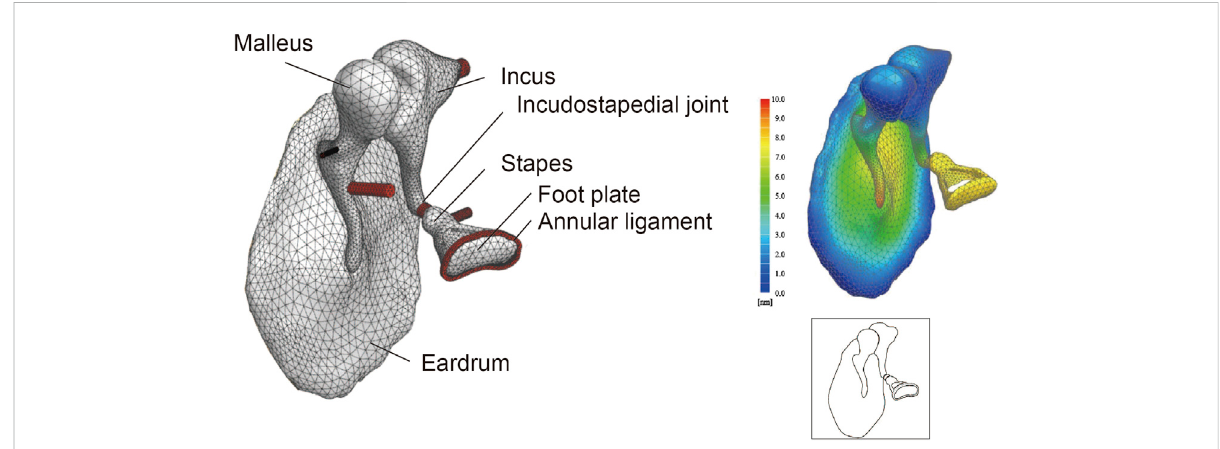
FIGURE 1 Finite element model (FEM) of the middle ear. Even complex shapes such as the eardrum and ear ossicles can be represented by a fi nite set of tetrahedron elements (49552 elements in this model). The displacement at any point can be measured by applying a set sound pressure, and the amount of displacement is displayed as a heat map. Illustrations such as that shown in the lower-right panel are used throughout this paper to summarize the